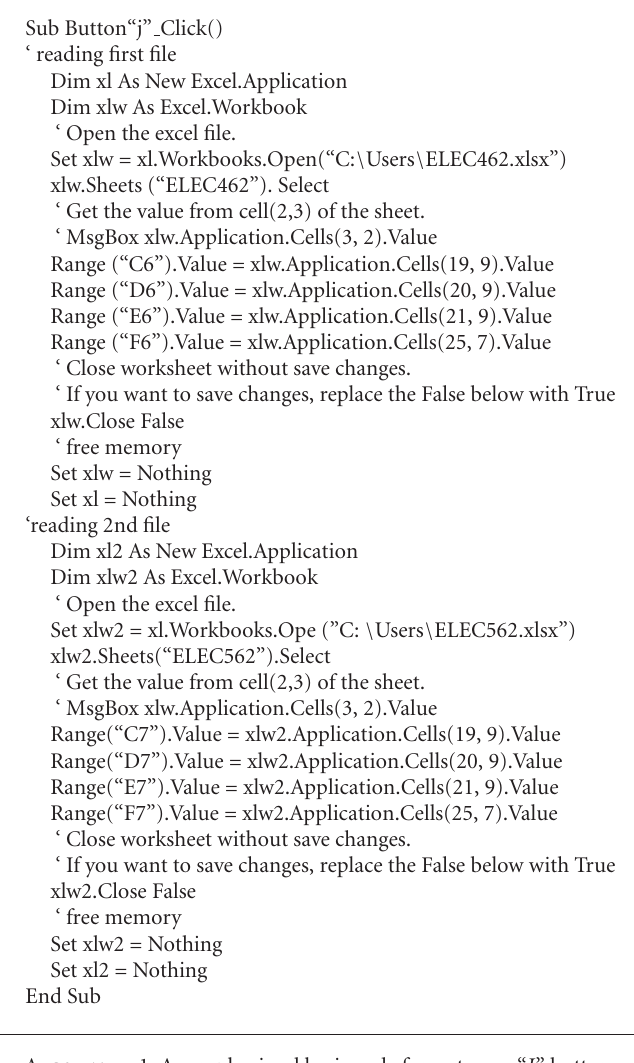
Algorithm 1: A sample visual basic code for outcome “ J ” button.